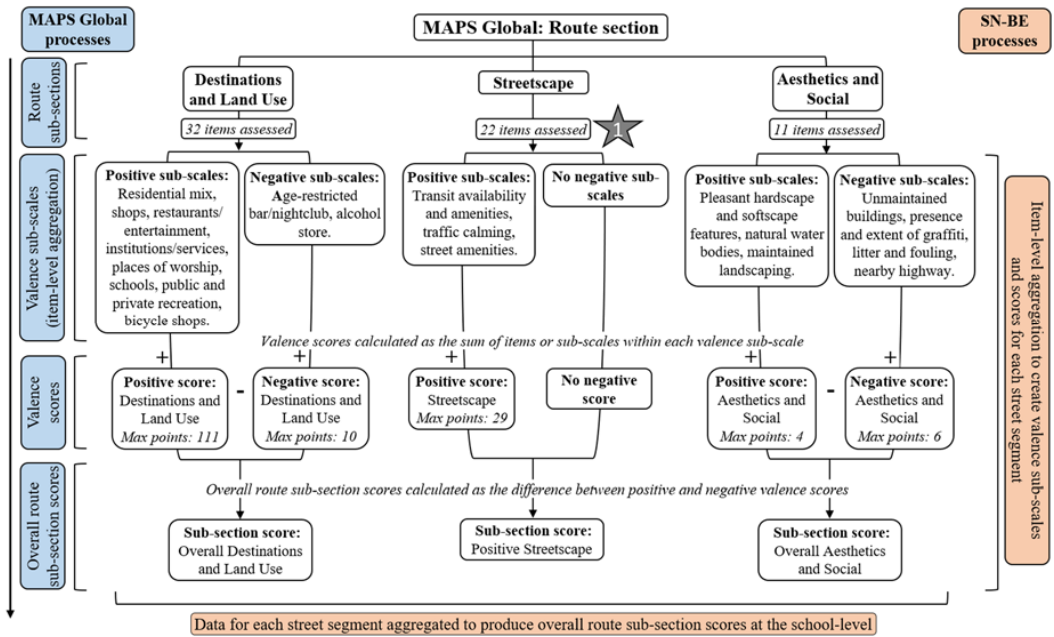
Figure 2. Hierarchical scoring system of MAPS Global route section and sub ‐ sections (adapted from [43]). Note. Star denotes number of item ‐ level modifications. Max points refers to the maximum number of points available from the summation of sub ‐ scales.